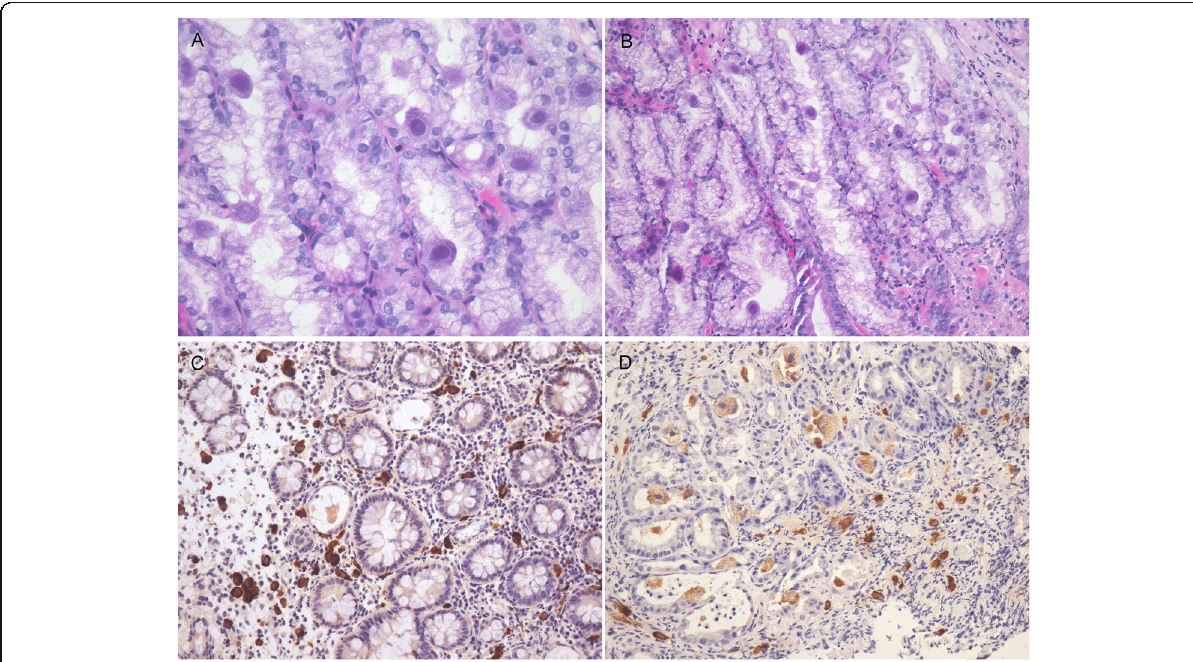
Fig. 1 CMV cell tropism in gastrointestinal tract from patients with HIV/AIDS. ( A ) CMV viral inclusions showed an ‘ eagle eye ’ appearance in some virus-infected cells, other CMV inclusions were characterized by abundant coarse eosinophilic cytoplasmic inclusions within enlarged cells. HE, original magnification 400×. ( B ) CMV mostly infected epithelial cells in duodenum. HE, original magnification 200×. ( C ) CMV mostly infected mesenchymal cells in colon (brown). ISH, original magnification 200×. ( D ) Epithelial cells and mesenchymal cells can be all infected by CMV in gastric antrum. ISH, original magnification 200